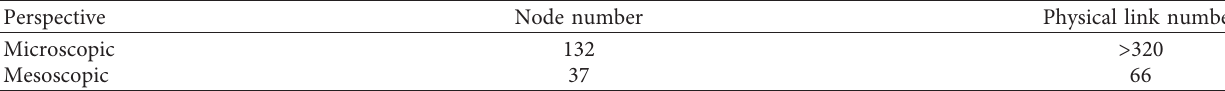
Table 7: Network size comparison from the microscopic and mesoscopic